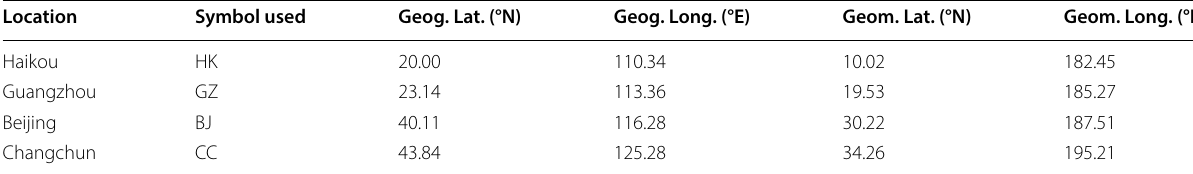
Table 1 Details of the digital ionosonde sites used in the investigation Location Symbol